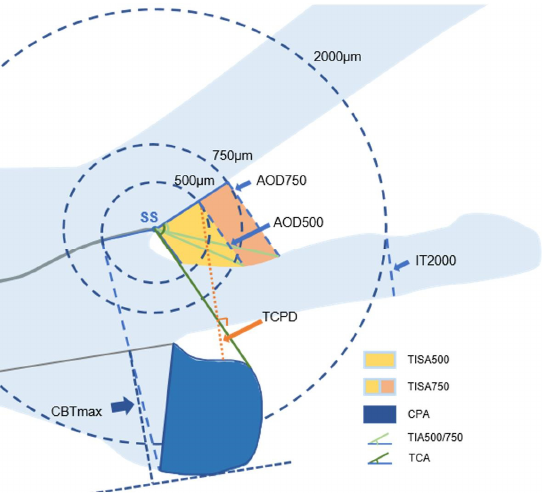
Figure 2. Anterior segment parameters on the radial scans at the superior, nasal, inferior, and temporal positions measured by ultrasound biomicroscopy (UBM). (Illustrator: K.Y.). IT 750/2000: iris thickness of 750 µm and 2000 µm from the SS; AOD 500/750: the distance between the posterior corneal surface and the anterior iris surface on a line perpendicular to the trabecular meshwork at 500 µm and 750 µm from the SS; TISA 500/750: the area bounded anteriorly by AOD 500 and AOD 750, as determined posteriorly by a line drawn from the SS perpendicular to the plane of the inner scleral wall to the iris, superiorly by the inner corneoscleral wall, and inferiorly by the iris surface; TIA 500/750: the apex of the angle at the iris recess and the arms of the angle passing through a point on the trabecular meshwork at 500 µm and 750 µm from the SS and the point on the iris perpendicularly opposite; CPA: the cross-sectional area of the ciliary process bounded laterally by a line connecting the insertion location of the iris into the ciliary body and the crosspoint of a line of 500 µm from the SS perpendicular to the plane of the inner scleral wall to the ciliary process, and internally by the ciliary process surface; TCA: the angle between the posterior corneal surface and the anterior surface of the ciliary body; TCPD: the length of the line extending from the corneal endothelium 500 mm from the SS perpendicularly through the posterior surface of the iris to the ciliary process; CBTmax: the thickest location of the ciliary body.